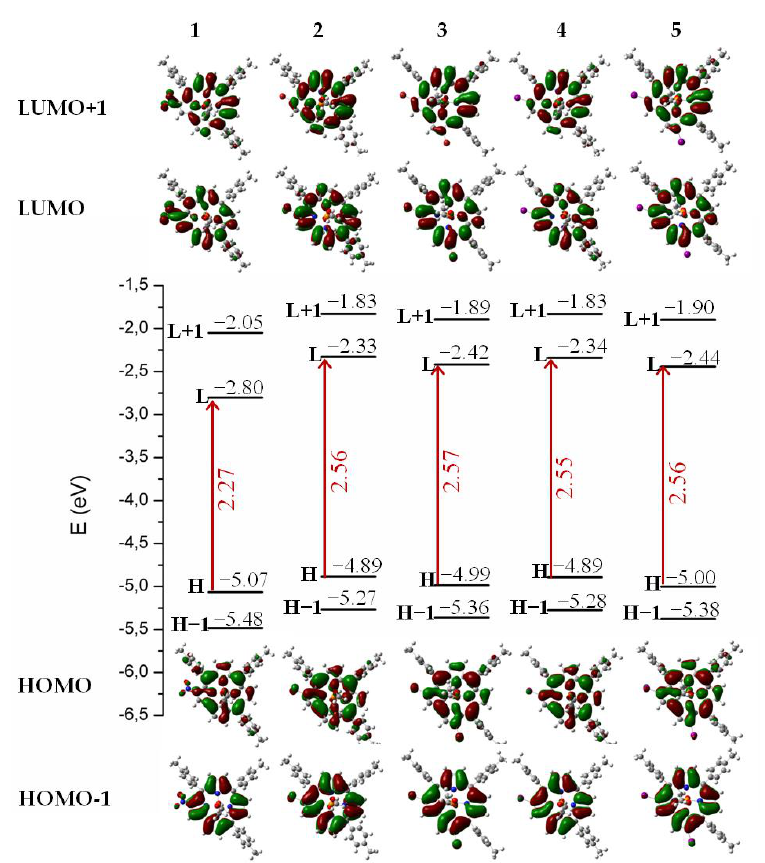
Figure 1. Energy diagram of the four Gouterman’s orbital and their counter plot for the ground states of compounds 1 – 5 . H-L energy gaps (eV) are indicated by solid red arrows. Table 2. Spin–orbit matrix elements (cm − 1 ) and singlet-triplet energy gaps (eV) calculated at the B3LYP/cc-pVDZ level of theory.